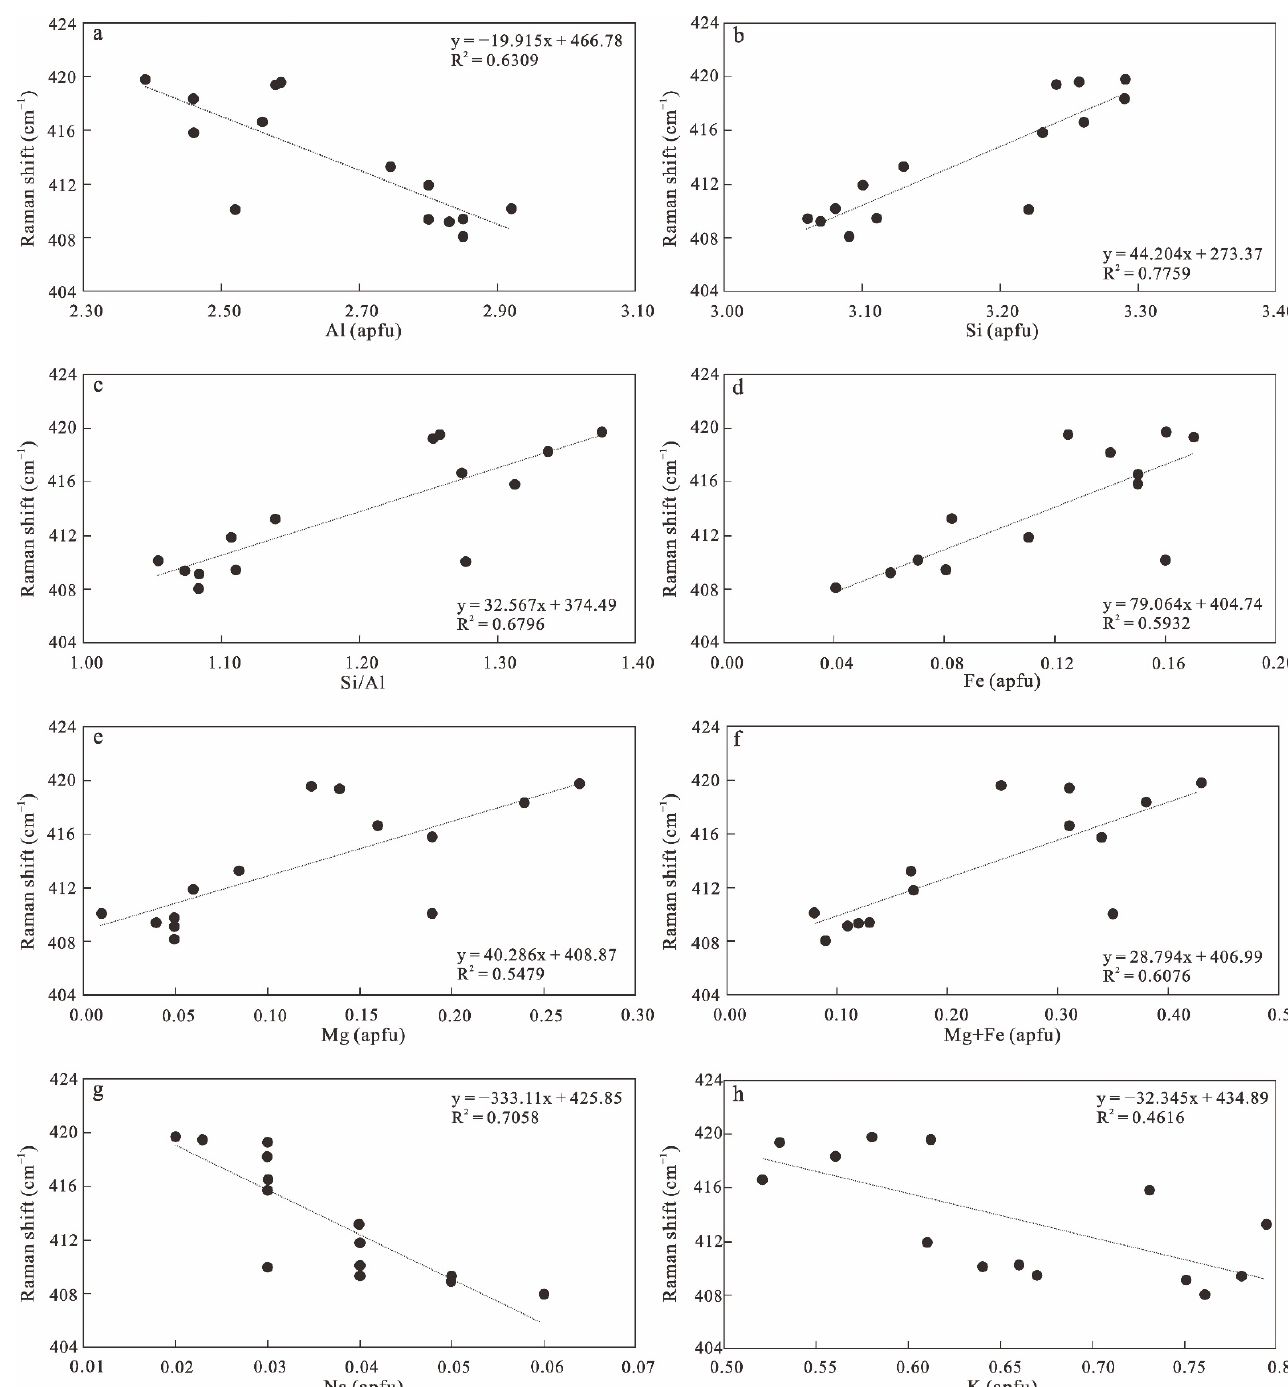
Figure 7. Binary diagram of Raman shift (Al, O (br)) for the Shimensi white micas vs. ( a ) Al; ( b ) Si; ( c ) Si/Al; ( d ) Fe; ( e ) Mg; ( f ) Mg + Fe; ( g ) Na; ( h ) K.